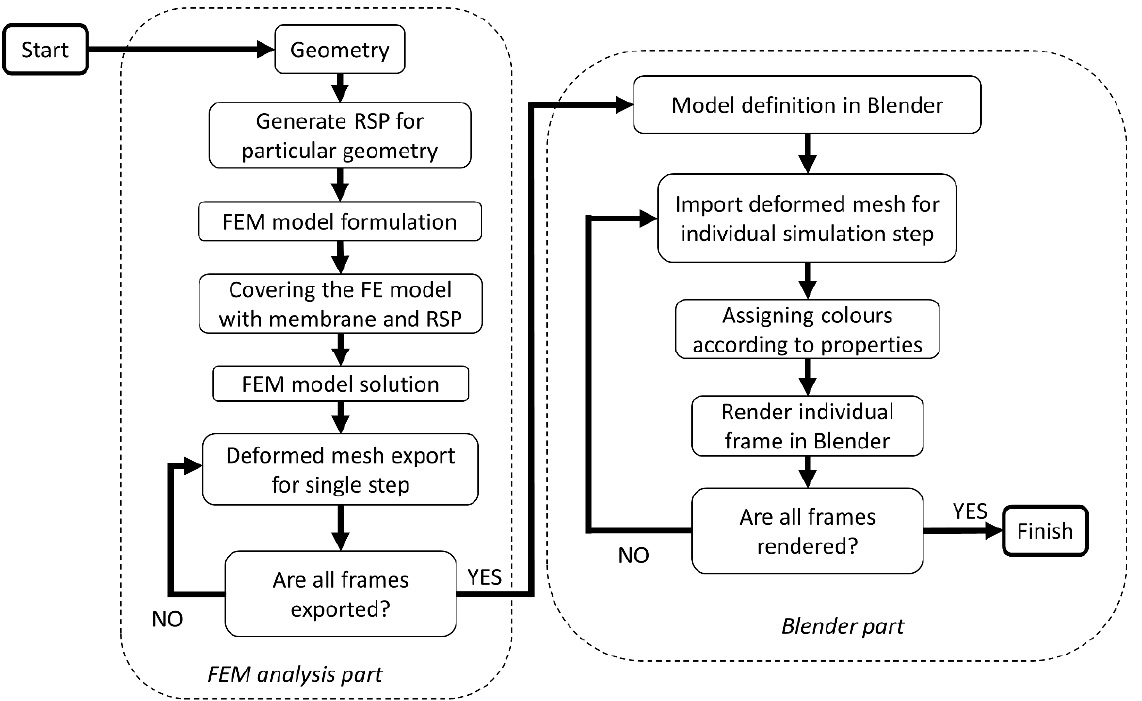
Figure 3. The scheme of the proposed simulation algorithm for video sequence generation with RSP.